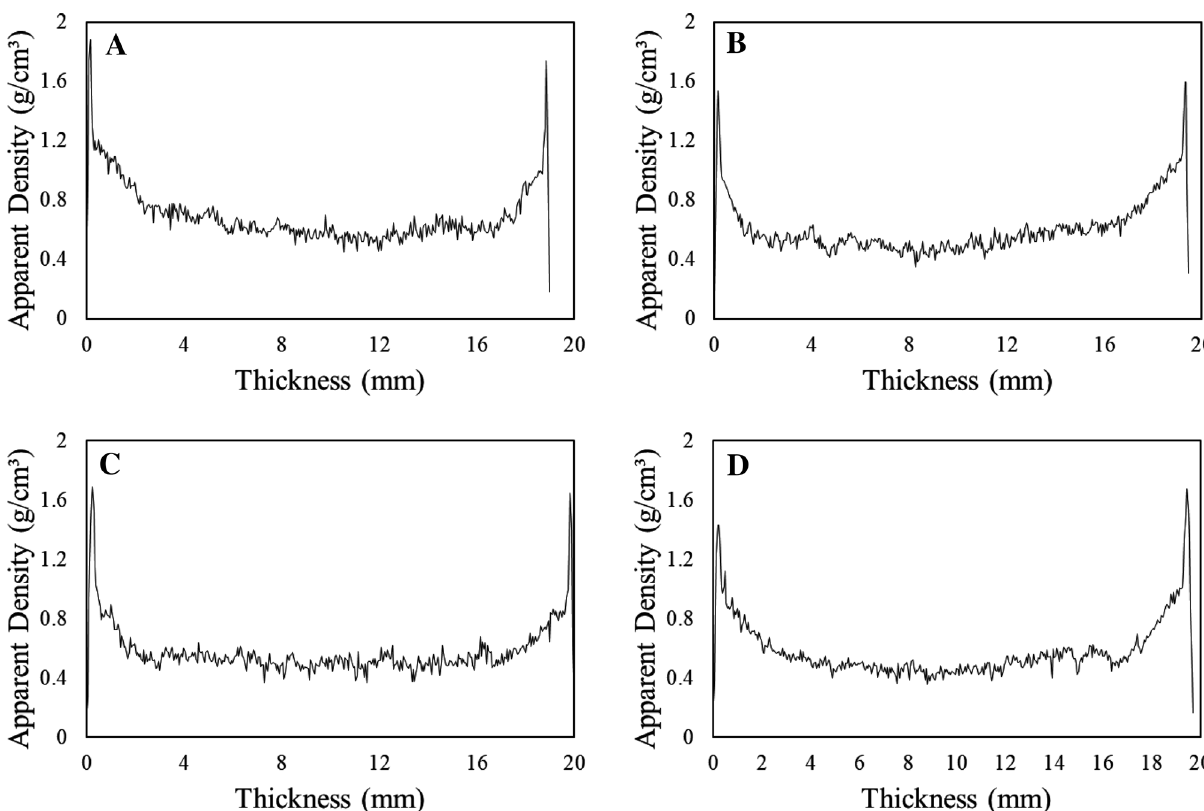
Figure 1. Apparent density profiles (AD) along the thickness of the coated MDF residues. Untreated ( A ); torrefaction for 20 min ( B ); torrefaction for 30 min ( C ); torrefaction for 40 min ( D ).